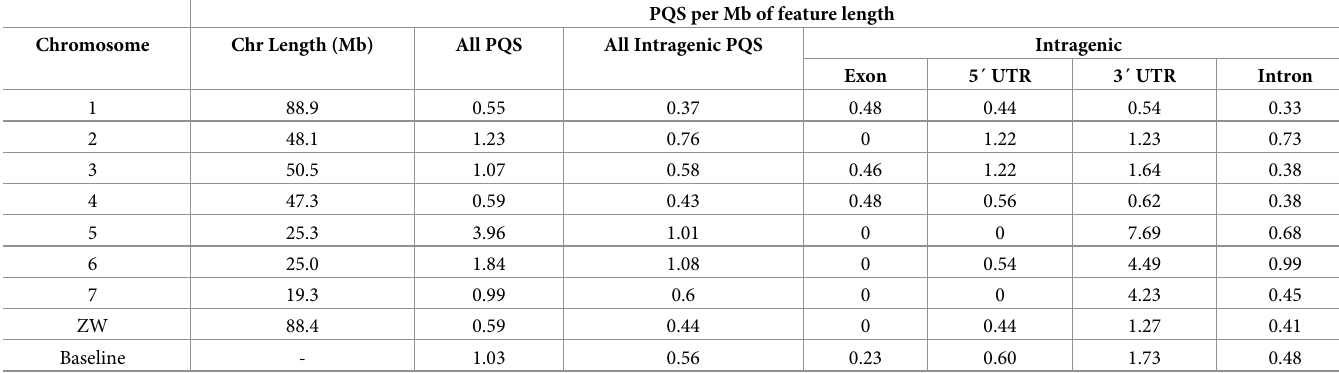
Table 3. PQS density characteristics (PQS/Mb) within each S . mansoni